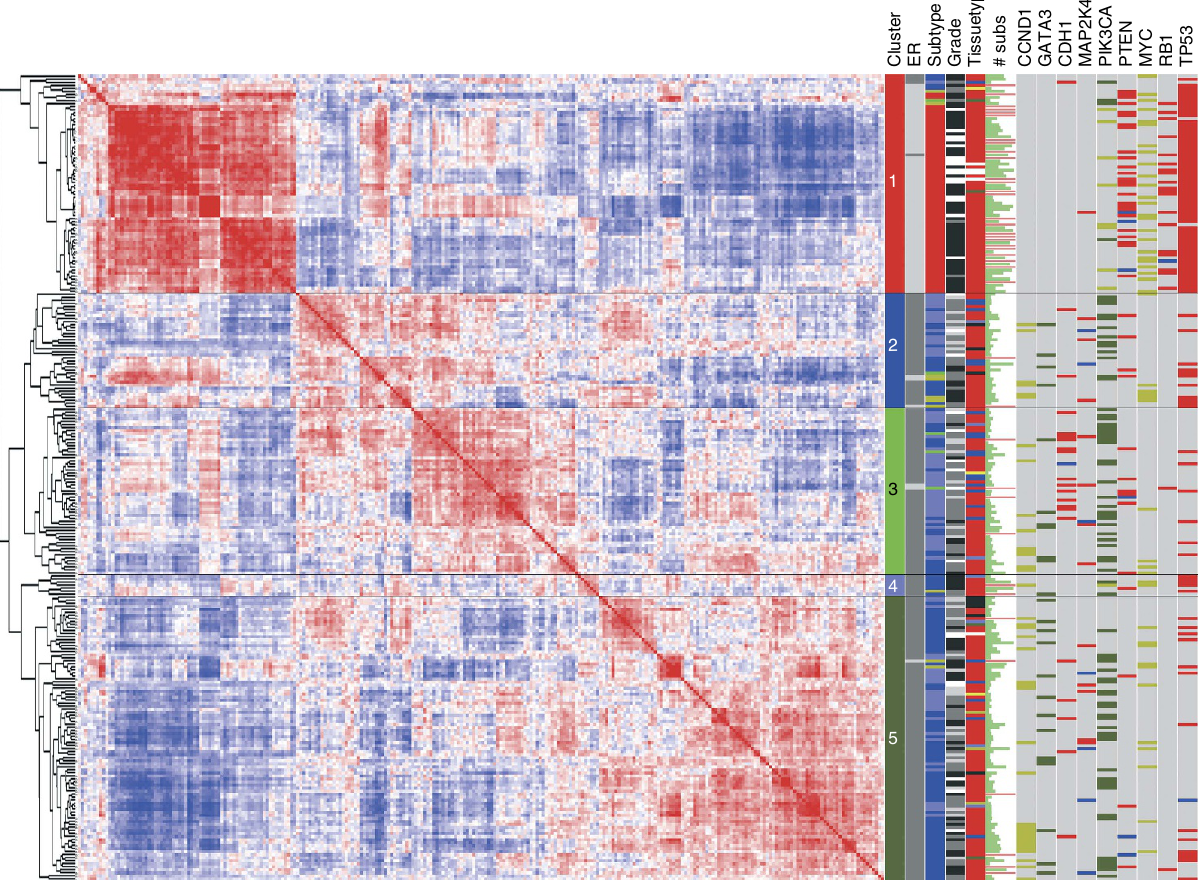
Figure 1 | Clustered correlation matrix of 266 breast cancer cases. The left panel shows the dendrogram and clustered correlation matrix (red is positive, blue negative correlation) of 266 breast cancer cases. The top 5,000 most variable transcripts were used for correlating the samples. For the columns in the right panel, colour codes are as follows: ER: ER-positive dark grey, ER-negative light grey. Subtype: Red, basal; dark blue, Luminal B; light blue, Luminal A; green, normal-like; and dark yellow, her2. Grade: white, NA; light grey, grade 1; grey, grade 2; and black, grade 3. Tissuetype: red, ductal; blue, lobular; light blue, micropapillary; grey, mucinous; dark yellow, papillary; yellow, apocrine; and dark green, other type. # subs: The length of the green bar is proportional to the number of substitutions. Cases with 4 10,000 substitutions are shown with a soft-red coloured bar of equal length. The remaining nine columns show the status of driver genes. Light grey, wild type; dark yellow, copy-number amplification; blue, homozygous deletion; and mutations (substitution, indels, rearrangements) are dark green if activating and red if